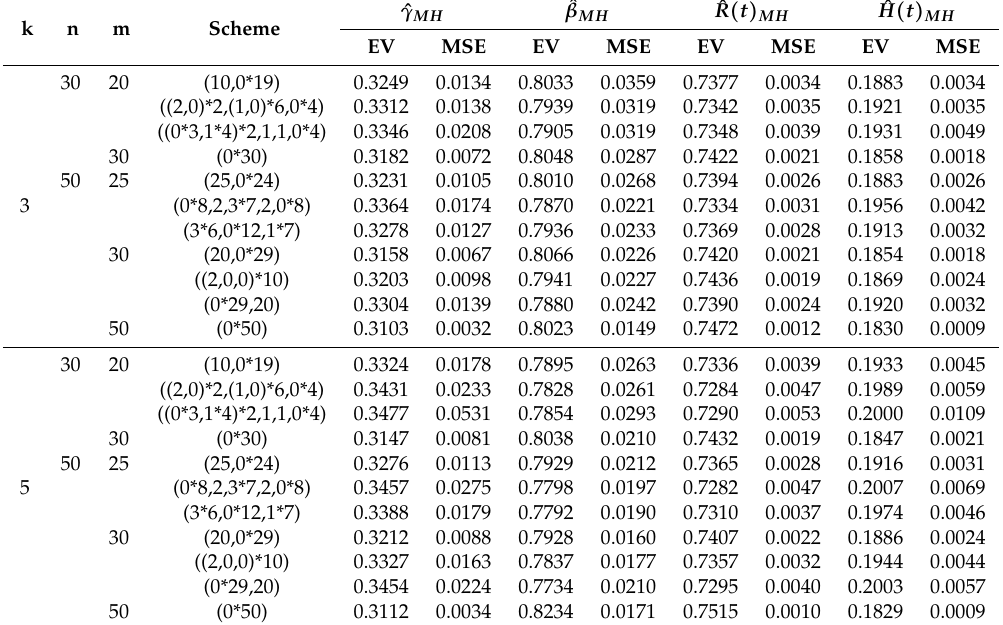
Table 18. Estimation values and MSEs of parameters, reliability and hazard functions using Metropolis-Hastings method under GELF when q = 1, γ = 0.3, β = 0.8, t = 1.5, a 1 = 1.08, b 1 = 3.6,